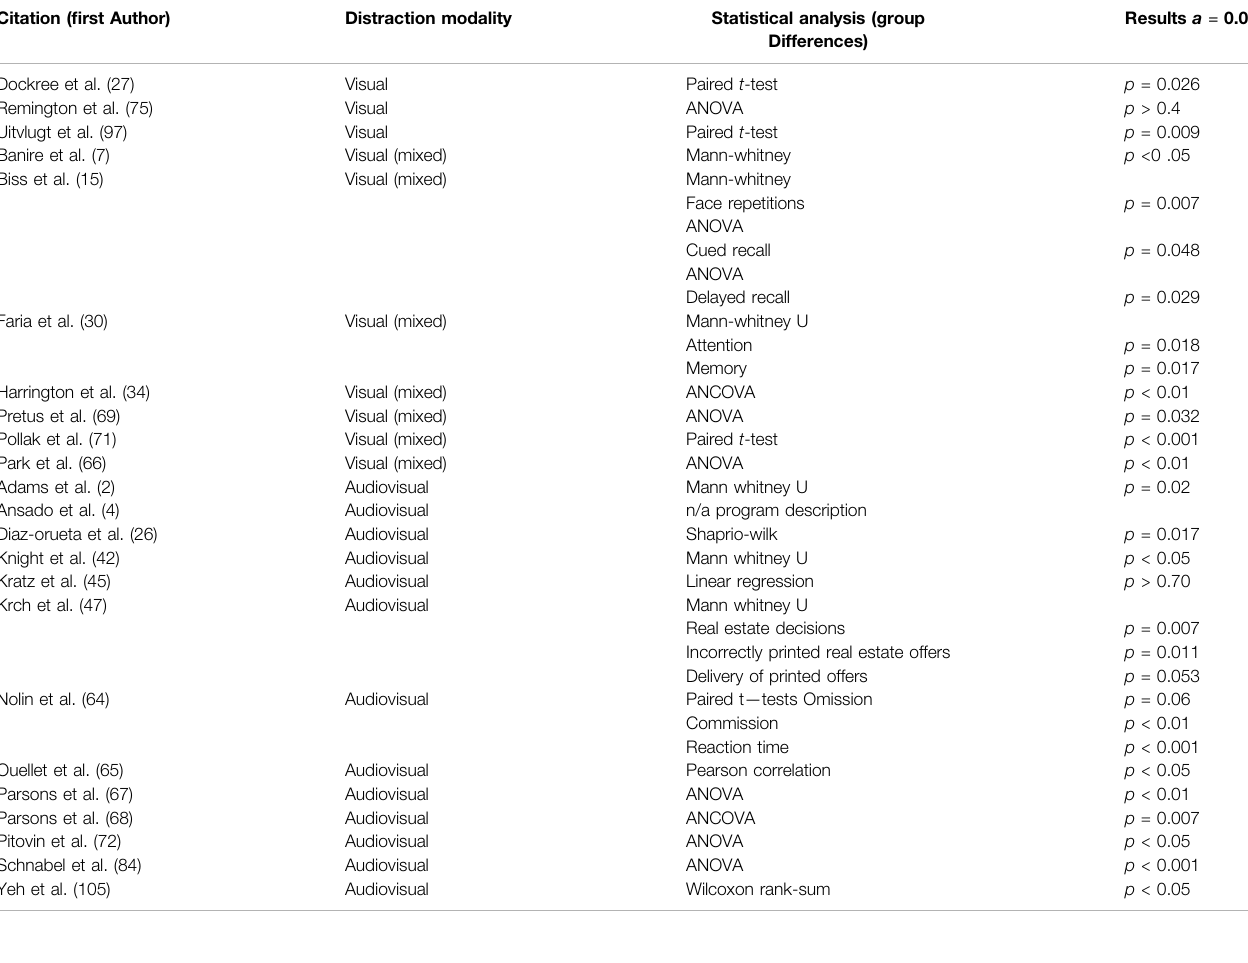
TABLE 1 | Between group comparison of performance with distraction present.